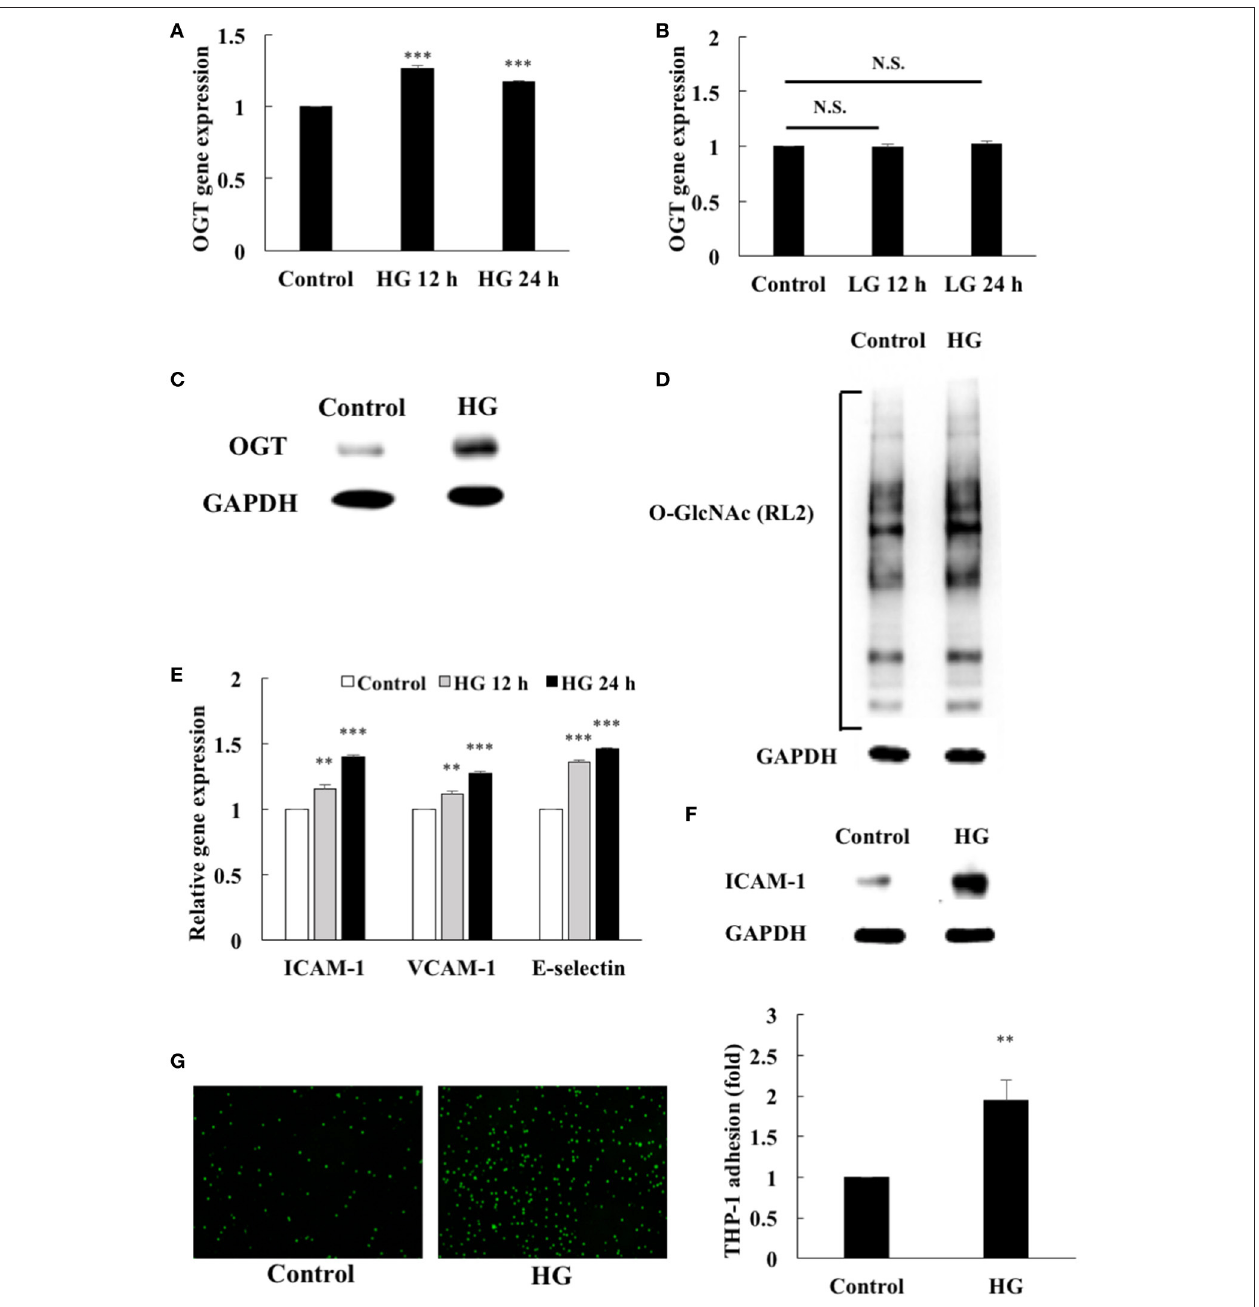
FIGURE 1 | Endothelial OGT expression, protein O -GlcNAcylation, and inflammatory phenotypes were induced by high glucose (HG). (A) HAECs were stimulated with HG (25mM) for 12 and 24h. Real-time PCR revealed that HG stimulation induced 1.27- and 1.17-fold increases, respectively, in OGT mRNA levels N = 5. *** p < 0.001 compared with control. (B) L-Glucose (LG) (25mM) did not modulate OGT mRNA levels N = 4. N.S. not significant. (C) Stimulation of the HAECs with HG for 24h induced a significant increase in OGT expression. The blot is representative of three independent experiments. (D) Stimulation of the HAECs with HG for 24h induced a significant increase in protein O -GlcNAcylation as detected using the RL2 antibody. The blot is representative of three independent experiments. (E) Stimulation of the HAECs with HG for 12 and 24h induced 1.15- and 1.40-fold increases, 1.11- and 1.27-fold increases, and 1.36- and 1.46-fold increases in ICAM-1, VCAM-1, and E-selectin gene expression levels, respectively N = 5. ** p < 0.01 and *** p < 0.001 compared with control. (F) Stimulation of the HAECs with HG for 24h induced a significant increase in ICAM-1 expression. The blot is representative of three independent experiments. (G) Stimulation of the HAECs with HG for 24h induced a 1.95-fold increase in THP-1 adhesion to HAECs N = 4. ** p < 0.01 compared with control.